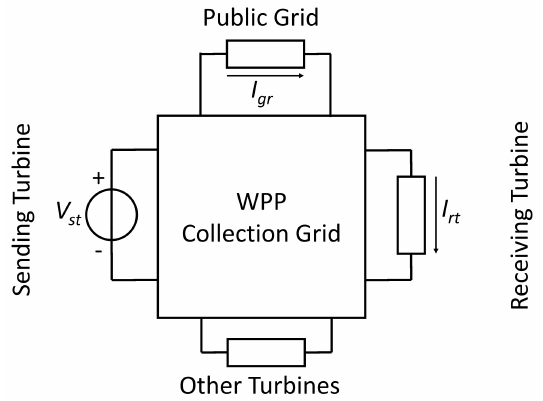
Figure A5. Multi-port representation representing transfer admittance from turbine to public grid and transfer admittance from turbine to turbine.